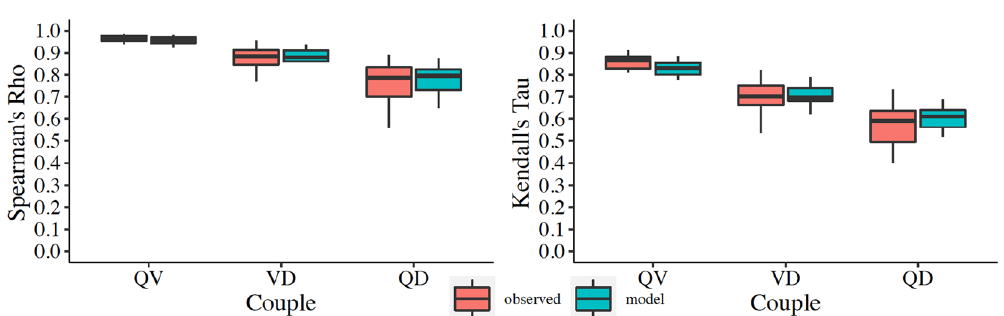
Figure 2. Comparison between observed (using 90th percentile of daily discharge as threshold) and simulated pairwise dependencies in terms of boxplots, for U.S subdataset. Spearman’s rho is in the left panel, and the Kendall’s tau in the right